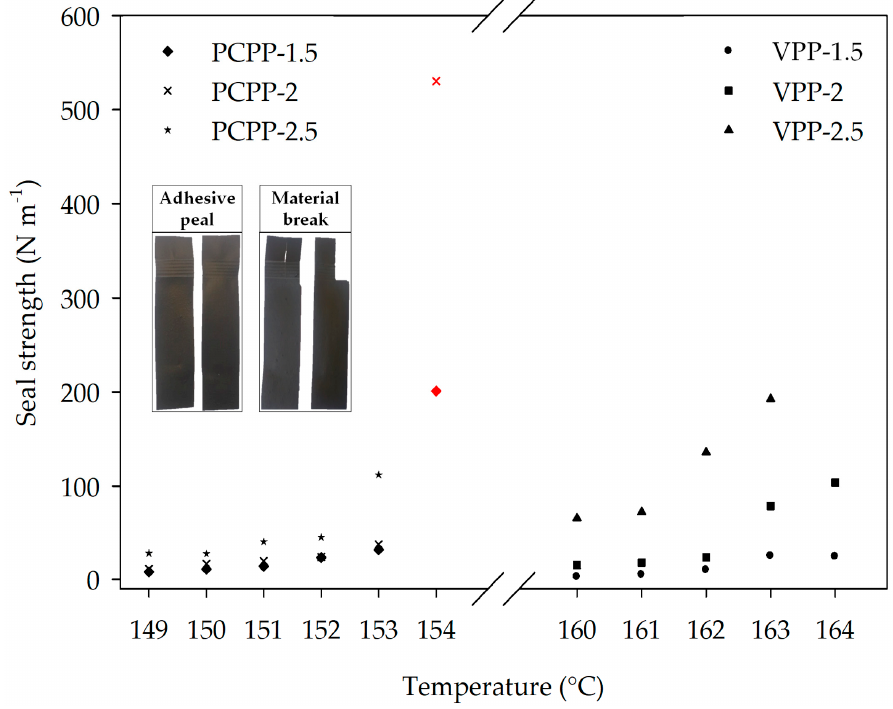
Figure 2. Sealing curves of commercial VPP and control PCPP films, designated as VPP-X and PCPP-X where X is the sealing time. Red symbols correspond to the temperature and time conditions where there was a failure “material break” type.